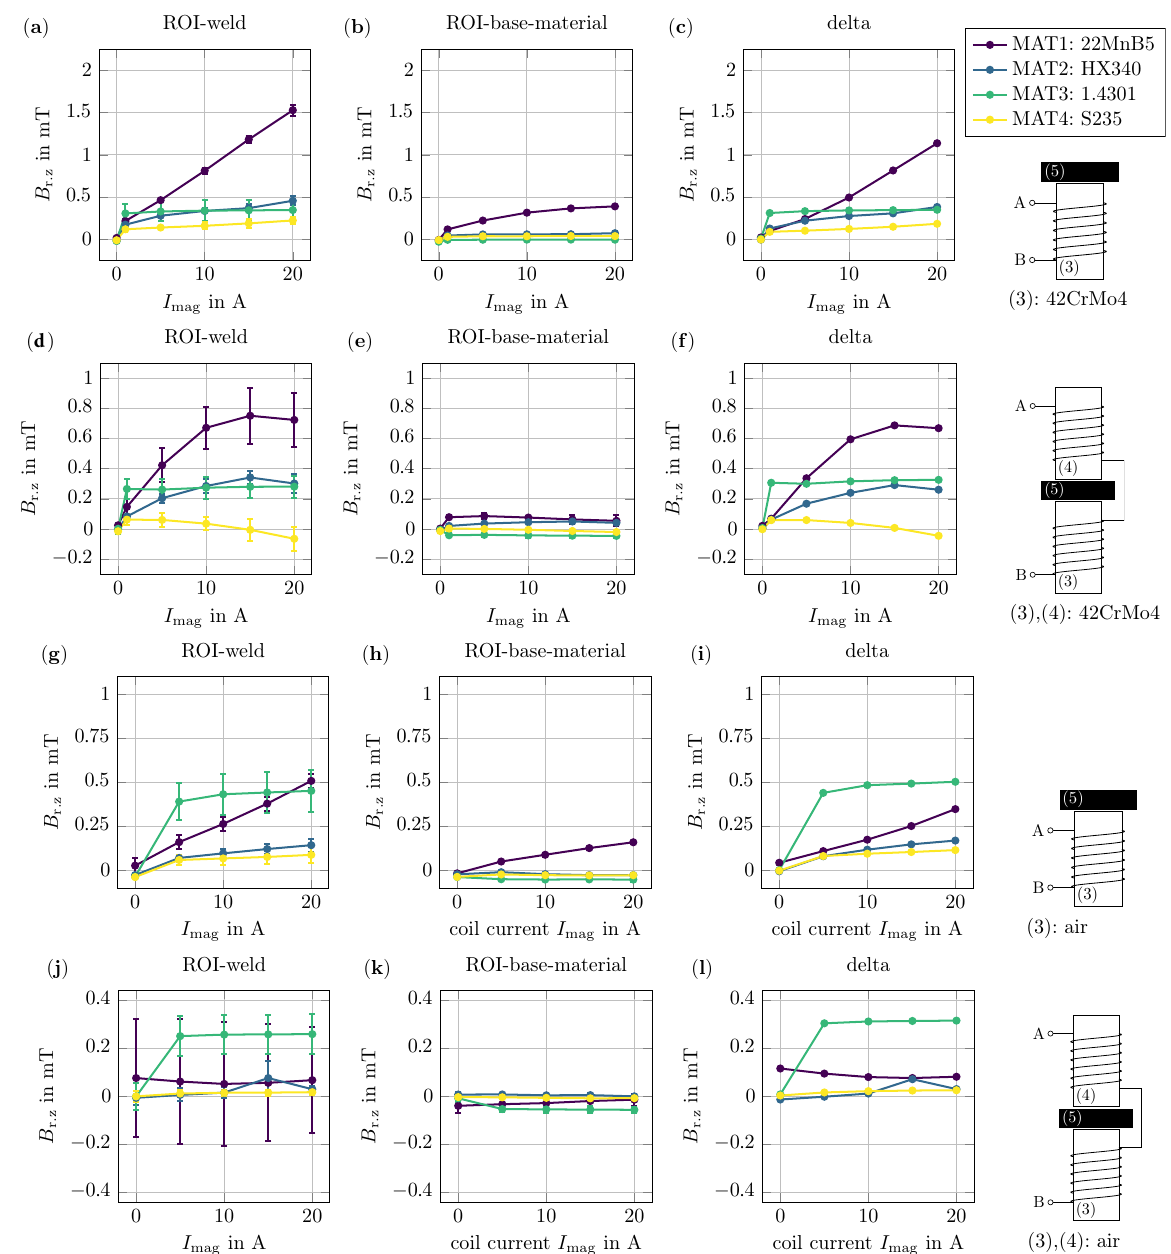
Figure 14. Mean values and standard deviations of the residual magnetic flux density in z -direction B r.z of the ROIs weld ( left ), base material ( center ), and the difference of both ROIs delta ( right ) for all configurations: S1 ( a – c ), S2 ( d – f ), A1 ( g – i ) and A2 ( j – l ) over increasing coil currents I mag . The mean values are calculated over the five discs per material at each coil current level I mag